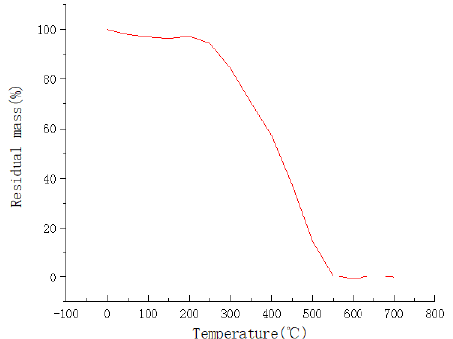
Figure 10. Thermogravimetric curve of epoxy resin adhesive.